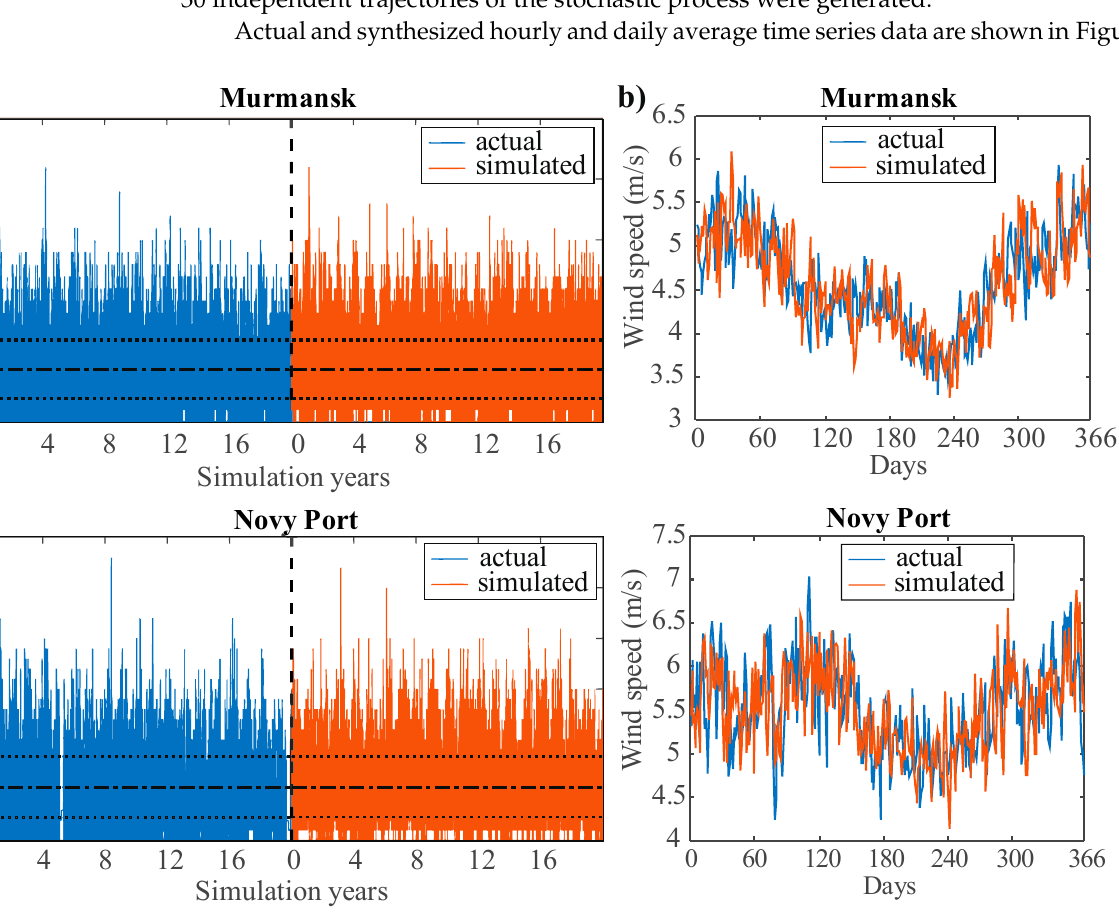
Figure 6. Actual and simulated wind speed time-series: ( a )—three-hour averaged, ( b )—daily averaged profile.